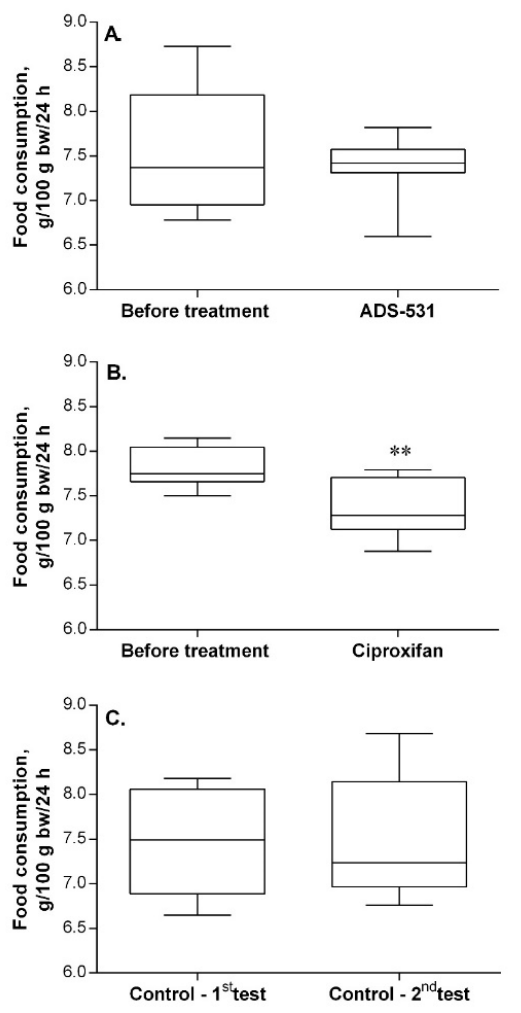
Figure 2. The effect of ADS-531 (s.c. 3 mg/kg/daily for five days), the newly synthesized histamine H 3 receptor antagonist (chart A ), and of the reference ciproxifan (s.c. 3 mg/kg/daily for five days; chart B ) on food consumption. Consumption by untreated rats (chart C ). Median (the line in the middle of the box) and the range of values (whiskers) are given for eight rats. Paired t -test, ** p < 0.01 vs. before treatment.